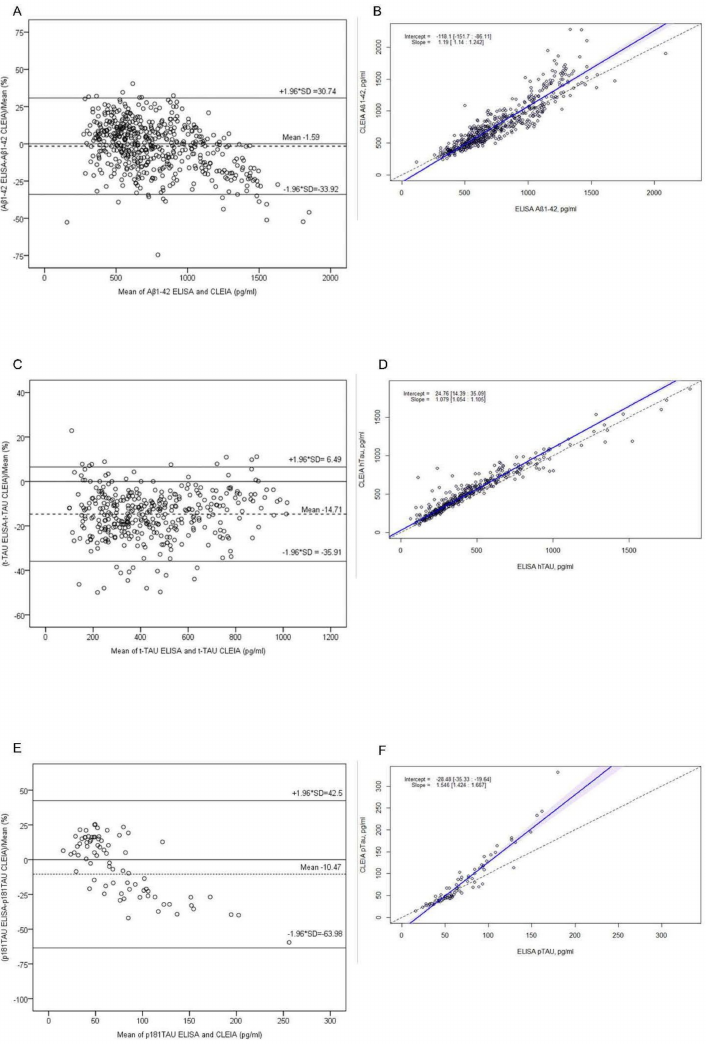
Figure 2. Bland–Altman ( A , C , E ) and Passing–Bablok analysis ( B , D , F ) for A β 42, hTAU, and p181TAU biomarkers comparing CLEIA with ELISA assay for A β 1-42 (n = 519), for t-Tau (n = 399), and for p181Tau (n = 77). For Bland–Altman analysis, the solid line shows 0 or no difference, while the dotted line shows the mean difference ± 1.96 standard deviation (SD). For Passing–Bablok analysis, dotted lines represent the equation x = y (identity line) and the blue areas show the 95% CI of the regression lines. Abbreviations: CLEIA,